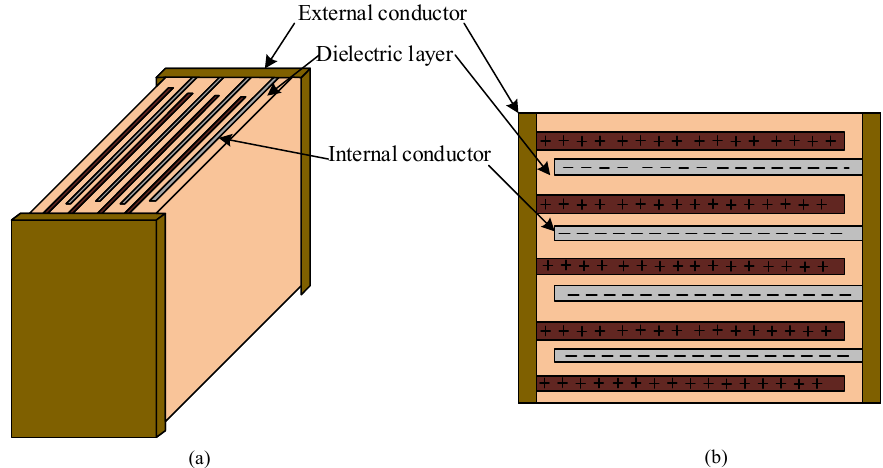
Figure 3. Construction of a high capacitance multilayer ceramic capacitor (MLC-Cap): ( a ) perspective view; ( b ) top view.